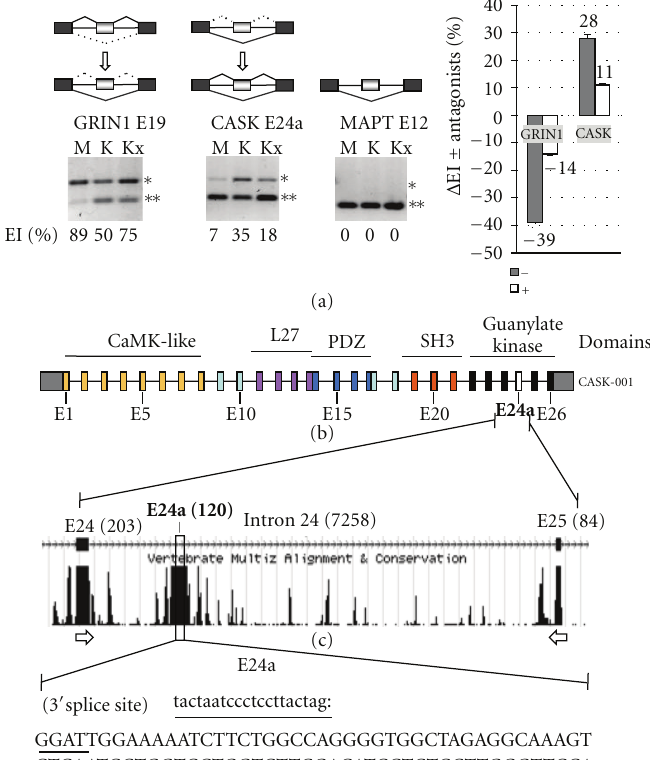
Figure 1: Identification of a highly conserved, responsive exon of the mouse CASK transcript. (a) RNA samples used for RT-PCR validation of splicing pattern changes were derived from cortical cultures following mock treatment (lanes M) or stimulation with high KCl (lanes K). Additional samples were supplemented with MK801 and APV to attenuate the splicing response (lanes Kx). Gel panels illustrate the exon included ( ∗ ) and skipped ( ∗∗ ) products amplified by primers specific for the flanking exons of GRIN1 E19 (left panel), CASK E24a (middle panel), and MAPT E12 (right panel). Numbers at bottom of gel panels represent the % exon inclusion (%EI) values for each lane. The schematics above summarize the observed changes in exon inclusion for E19 and E24a and the unresponsive exon-skipping pattern of E12. Graph at right shows the change in exon inclusion ( Δ EI) values for E19 and E24a as a function of stimulation with (white bars, +) and without (grey bars, − ) MK801 and AP5. (b) The exon-intron structure of the mouse CASK gene is shown using the exon-numbering scheme from the Ensembl CASK-001 transcript; corresponding protein domains (color-coded) are shown above. The position of E24a (white box) as identified in this study is shown. (c) Expanded region shows the sequence conservation of E24a (Multiz Alignment) and its position in the context of the full-length intron 24. Exon/intron sizes (base pairs) are indicated in parentheses. Note that the sequence of mouse E24a corresponds to coordinates 12,688,825–12,688,945 on the X chromosome from UCSC Genome Browser, 2006 genome assembly. Arrows indicate primers used for the RT-PCR analysis of (a). (d) The confirmed sequence of E24a (uppercase) and adjacent 5 (cid:2) and 3 (cid:2) -splice sites (underscored) are shown. Colons indicate exon/intron